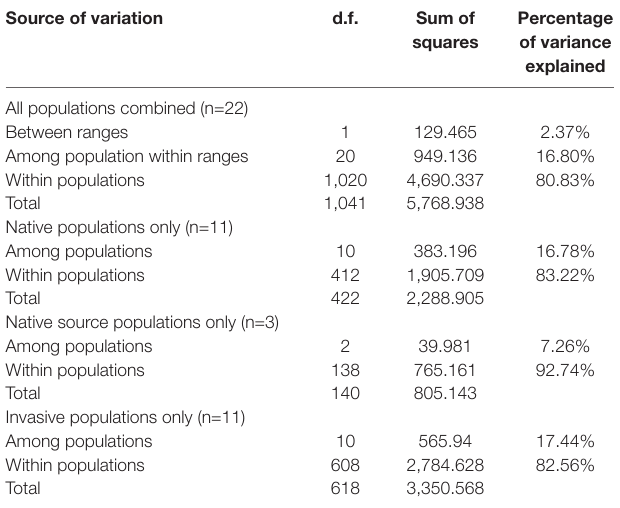
TaBle 2 | Results of AMOVA showing distribution of genetic variation of S. alterniflora in US and China based on microsatellite dataset.